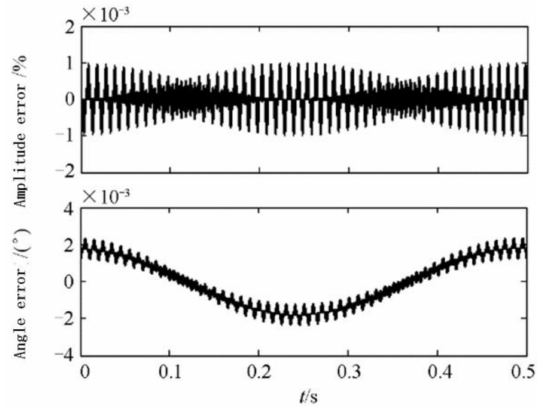
Figure 9. Phasor measurement error under the condition of frequency